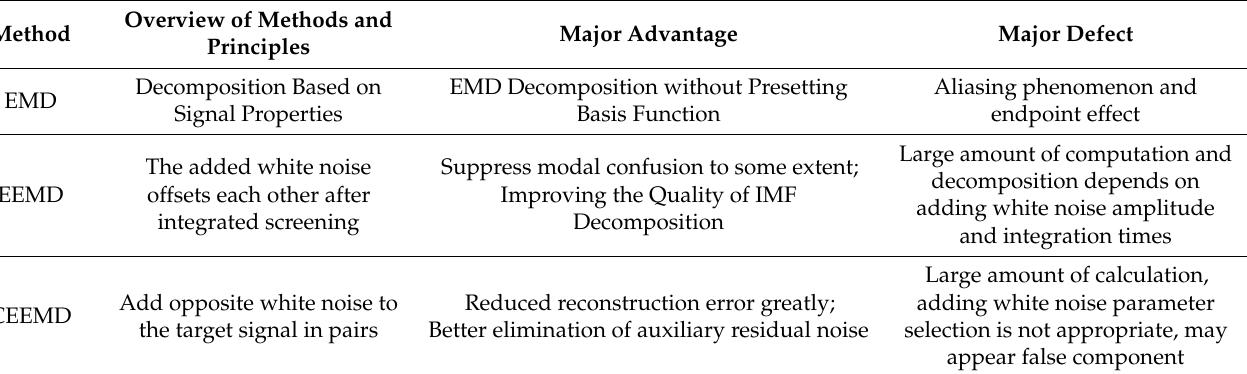
Table 5. Advantages and disadvantages of three decomposition